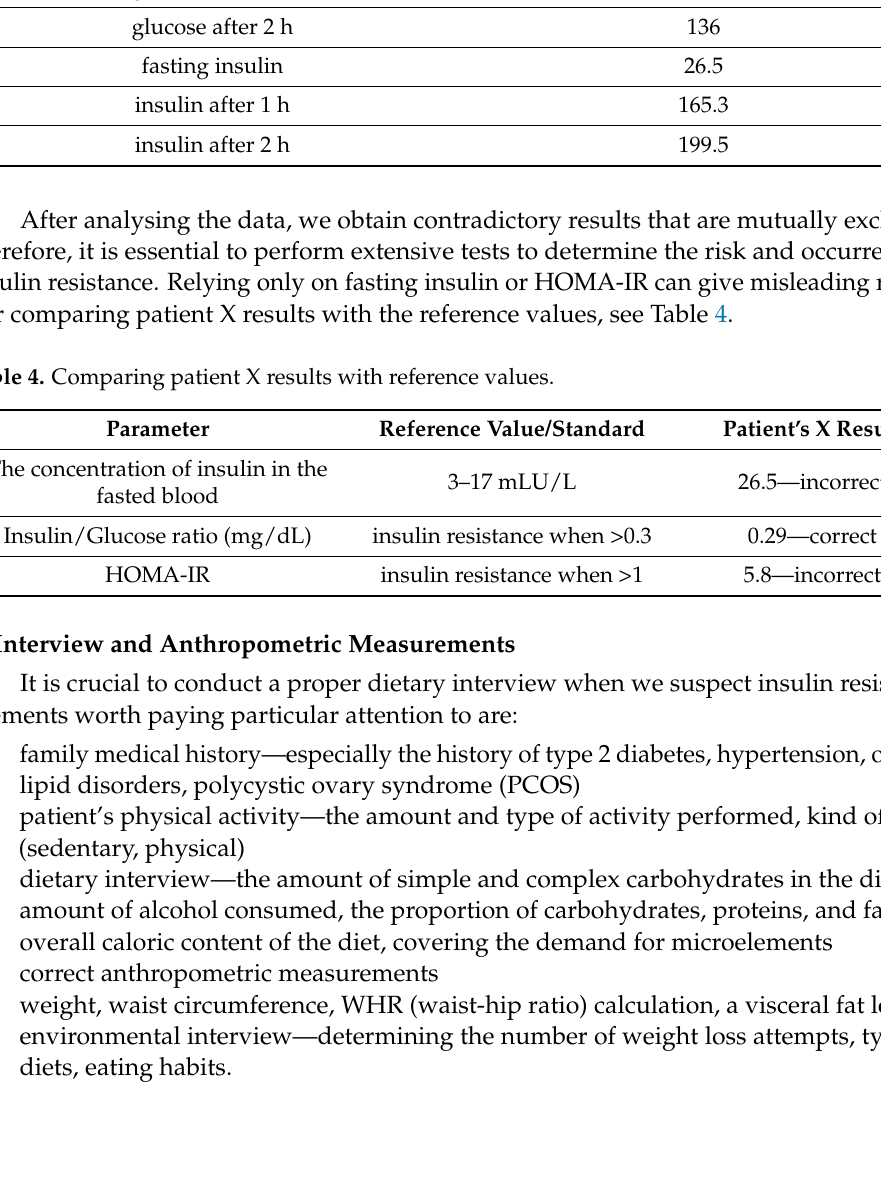
Table 3. Patient X serum concentrations of selected parameters. Parameter